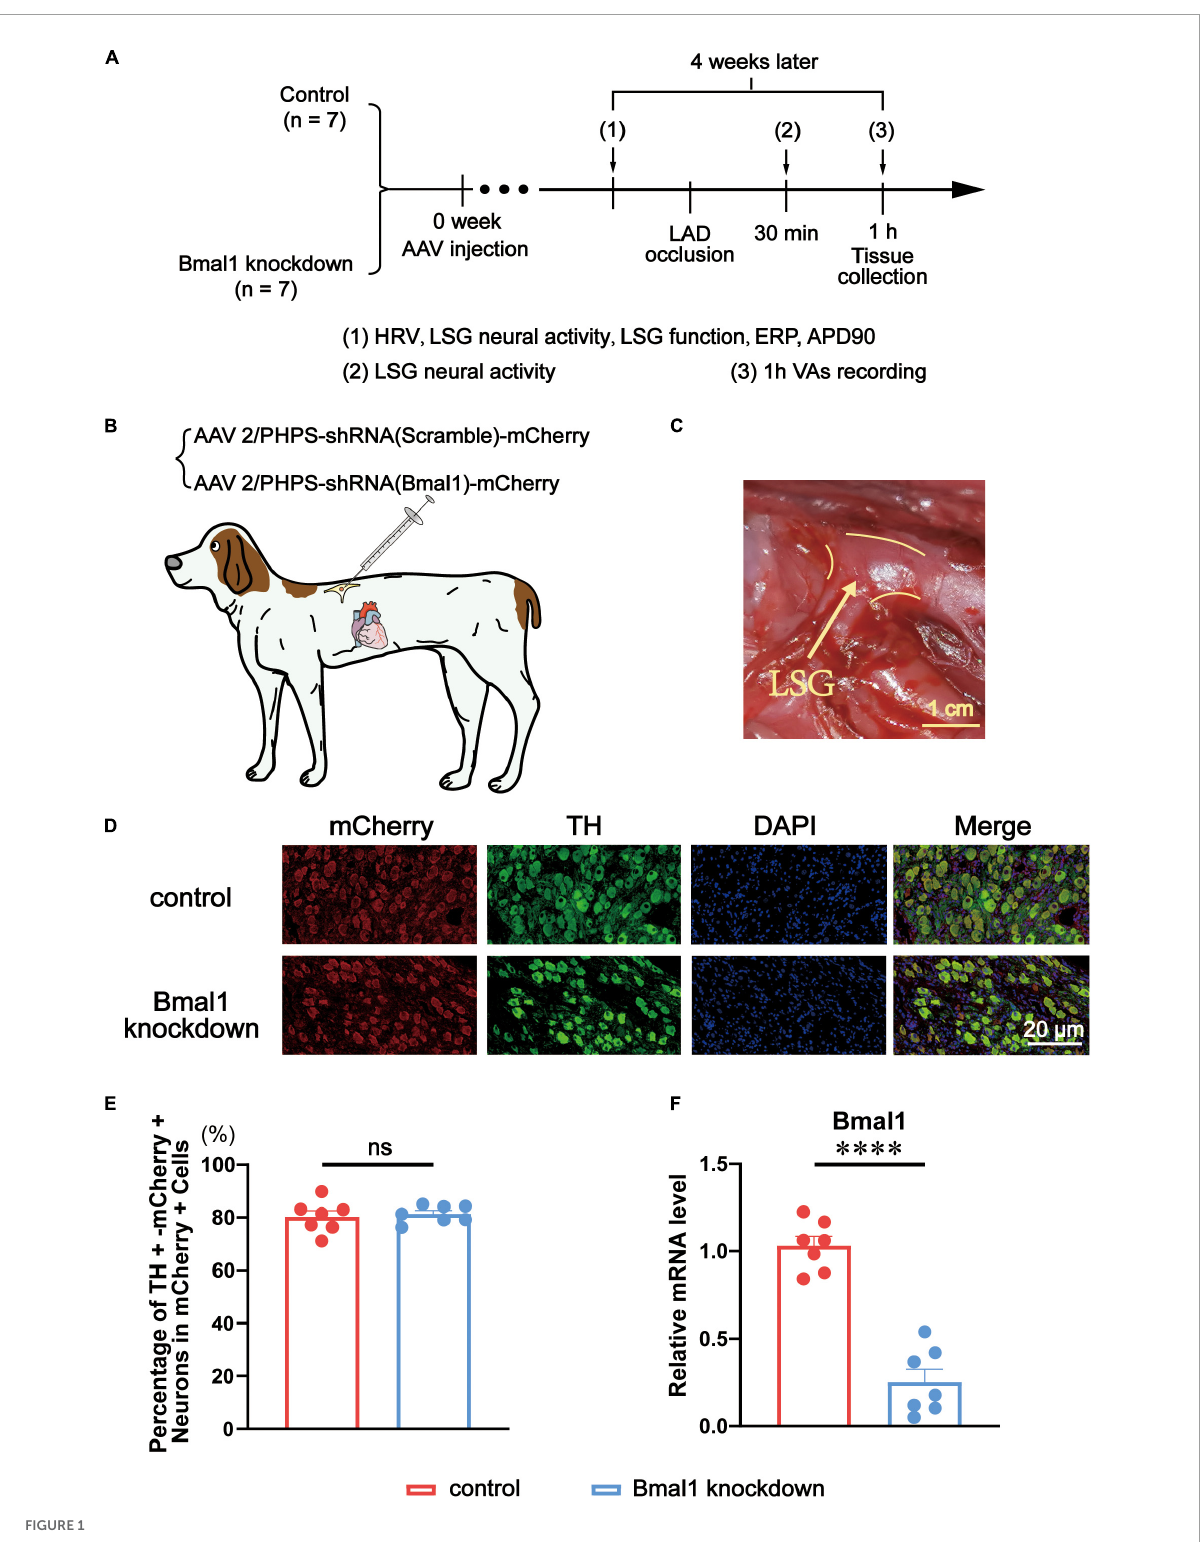
FIGURE1 Evaluation of Bmal1 knockdown in the LSG. (A) Flowchart of the experiment. (B) Schematic diagram of virus microinjection in canines’ LSG. (C) The anatomical location of the LSG. (D,E) The percentage of TH + mCherry + neurons in mCherry + cells. (F) The expression of Bmal1 was analyzed by quantitative RT-PCR. n = 7 for each group. ∗∗∗∗ p < 0.0001. ns, p > 0.05. AAV, adeno-associated virus; HRV, heart rate variability; LSG, left stellate ganglion; ERP, effective refractory period; APD, action potential duration; LAD, left anterior descending coronary arteries; VAs, ventricular arrhythmias; TH, tyrosine hydroxylase; DAPI,